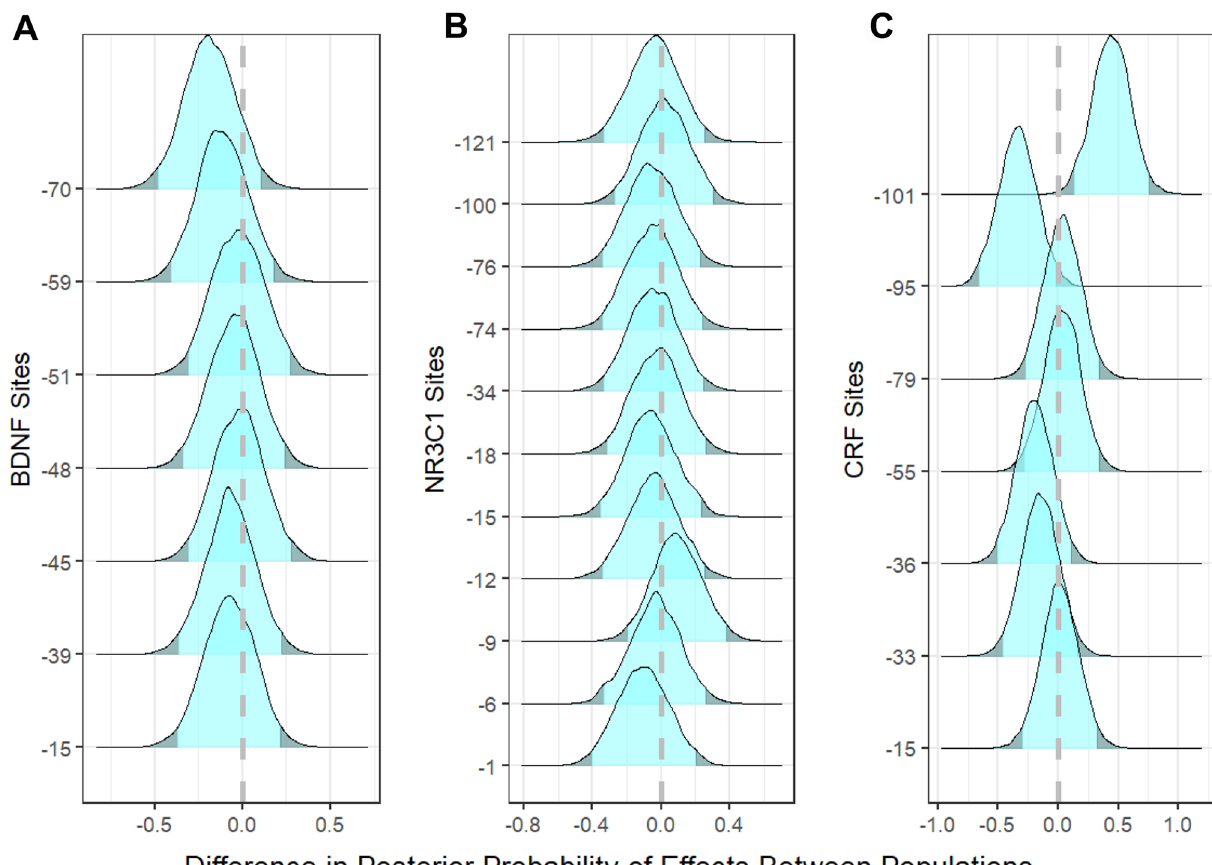
Figure 3. Differences in the posterior probability distributions of estimated effects between Northern and Southern Resident killer whale populations. Included are estimates for each CpG site identified by their distance from the TSS for (A) BDNF, (B) NR3C1 and (C) CRF. Positive values indicate Southern Residents are hypermethylated compared to Northern Residents and negative values indicate hypomethylation in